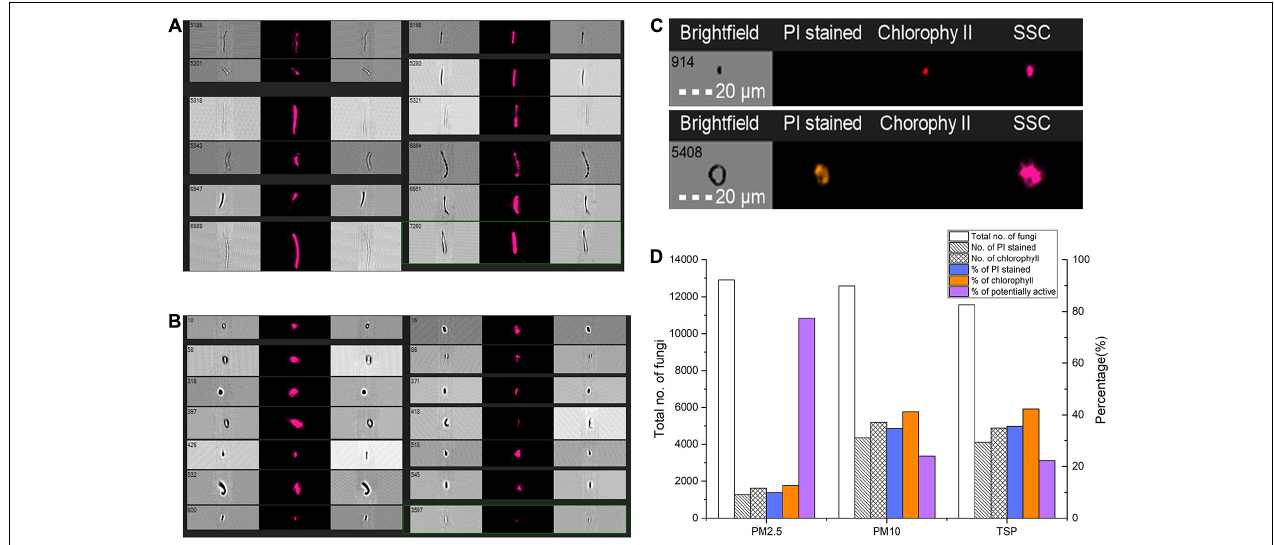
FIGURE 5 | Potential transcriptional active fungi detected by FlowSight R (cid:13) imaging flow cytometry. (A,B) Different forms of particles in FlowSight Amnis’s working process. (C) The imaging of different particles or fungal spores with propidium iodide (PI) staining. (D) The proportion of potentially active fungi in samples of different aerodynamic